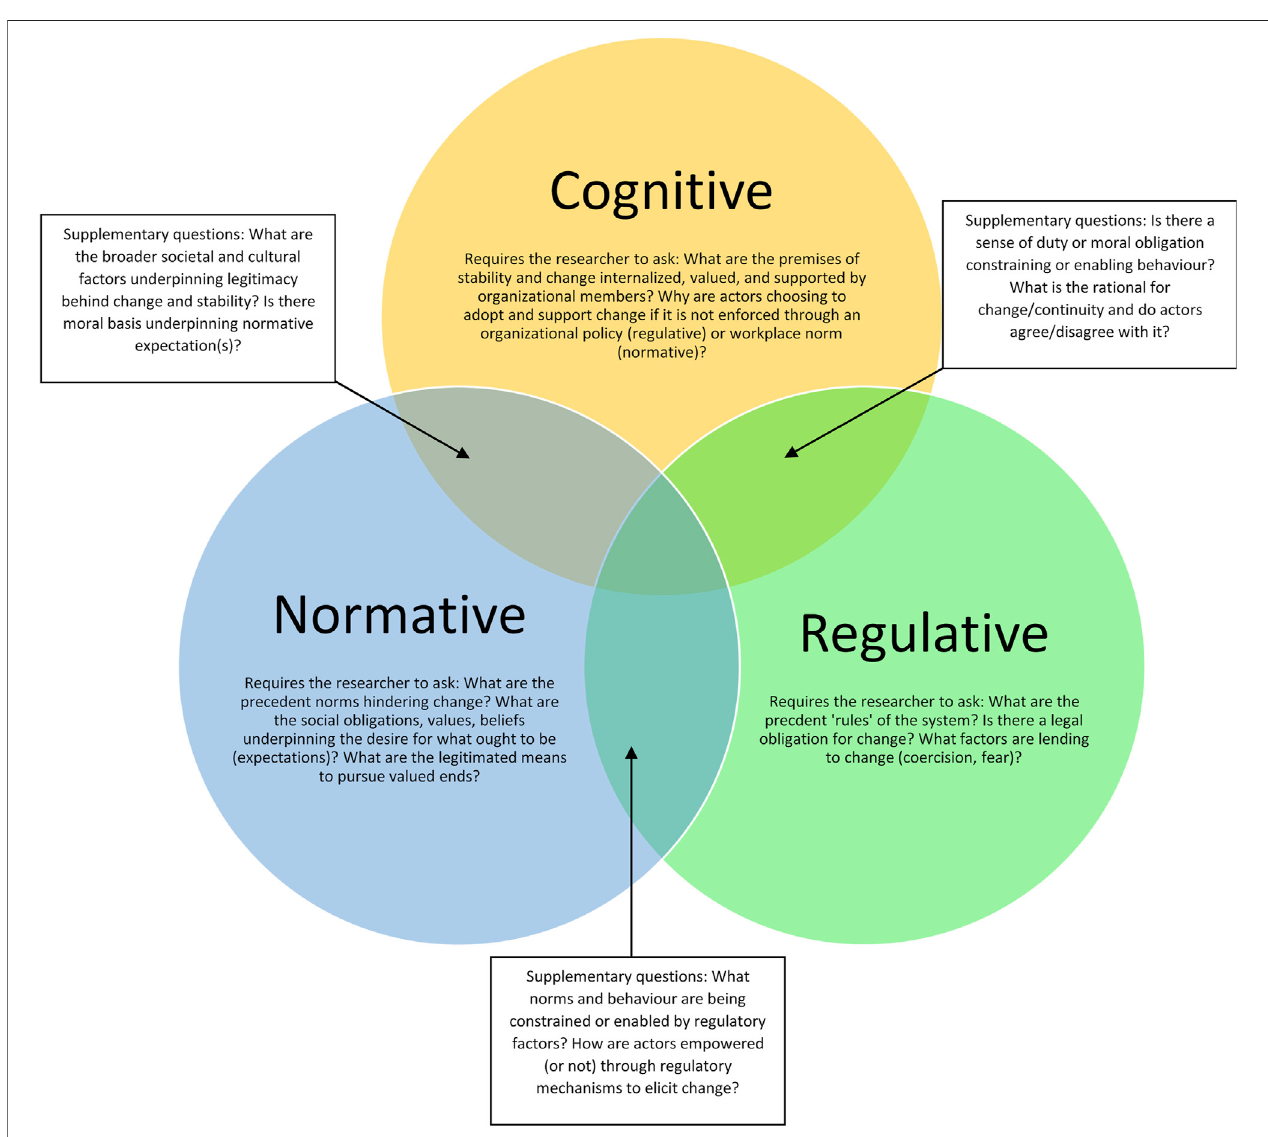
FIGURE 2 | Considering the cognitive, normative, and regulative elements lending to ideational and institutional power dynamics in food policy development.